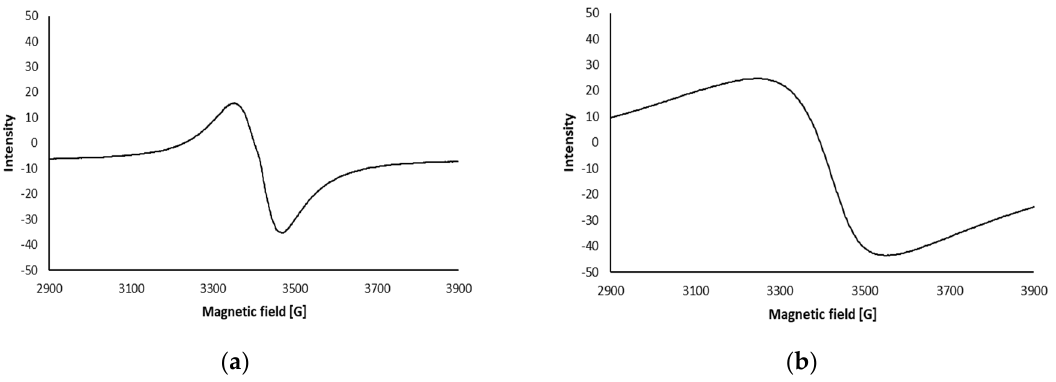
Figure 2. ESR spectra of deionized WST after the 15 ( a ) and 30 ( b ) min treatment.